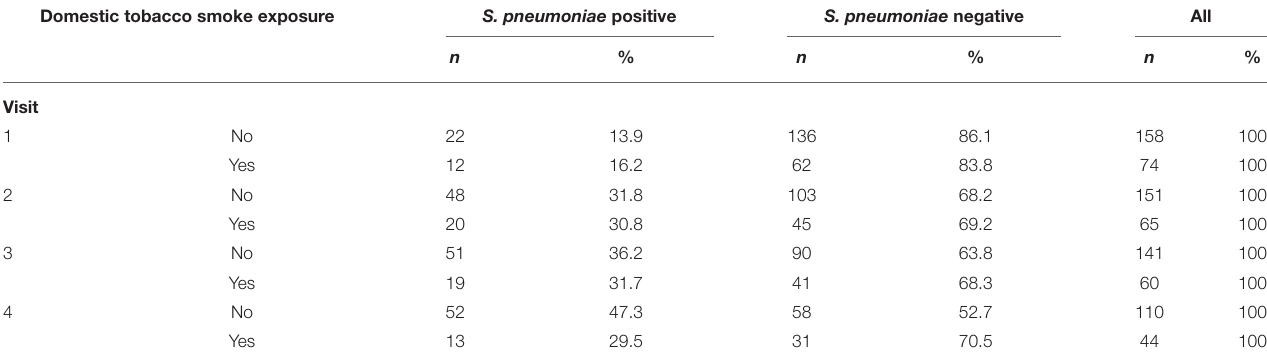
TABLE 7 | Domestic tobacco smoke exposure and pneumococcal colonization. Domestic tobacco smoke